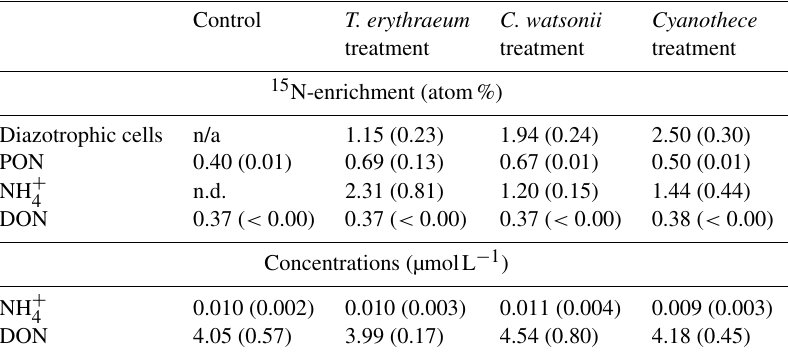
Table 2. 15 N-enrichment (atom%) of diazotrophic cells, PON, NH + parenthesis are shown the standard deviations on triplicate incubations. n/a: not applicable, n.d.: not